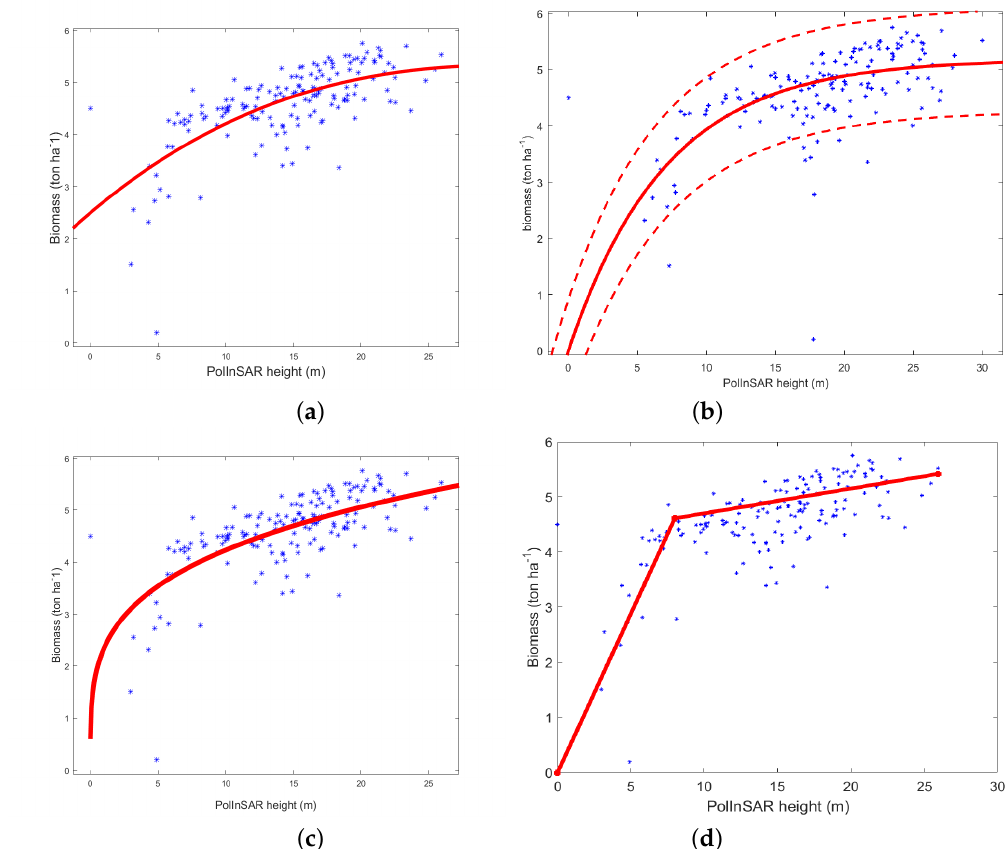
Figure 9. Relation between logarithm of measured biomass and RMoG L height resulting of the ( a ) polynomial ( R 2 = 0.42), ( b ) exponential ( R 2 = 0.67) with prediction bounds within a 95% confidence interval calculated by the LAR method ( c ) power series models ( R 2 = 0.54), and ( d ) piece-wise linear model ( R 2 = 0.60). The biomass values on vertical axis represent ln ( B ) .